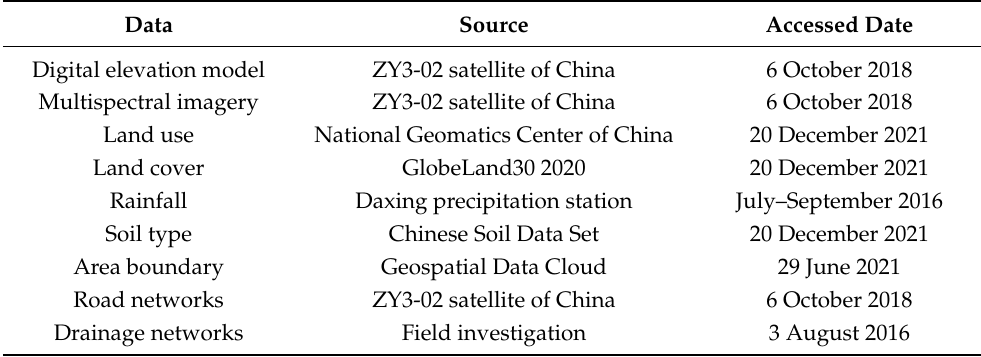
Table 2. Geographical and hydrological data acquisition and